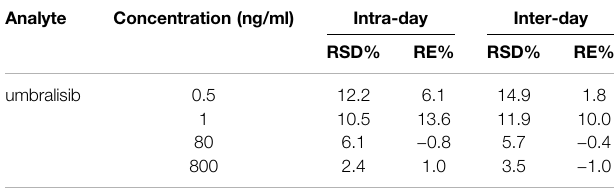
TABLE 2 | The precision and accuracy of umbralisib in rat plasma ( n (cid:1) 6). Analyte Concentration (ng/ml) Intra-day Inter-day